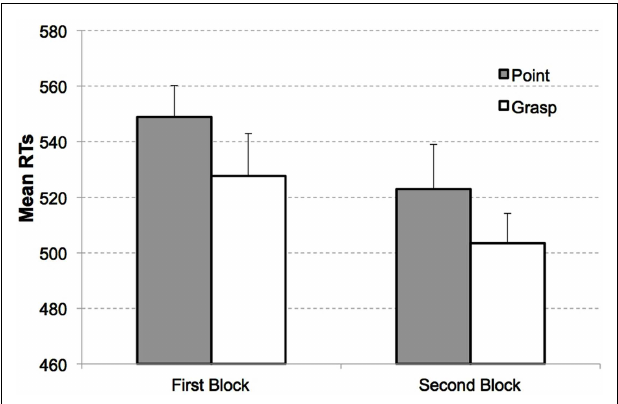
FIGURE 2 | Mean RTs as a function of congruency and block in Experiment 1. Congruent (white bars) and incongruent condition (gray bars) for target present displays in the first block (left) and second block (right). Error bars indicate the standard errors of the mean, adapted to within-participants designs, according to procedure described in Cousineau